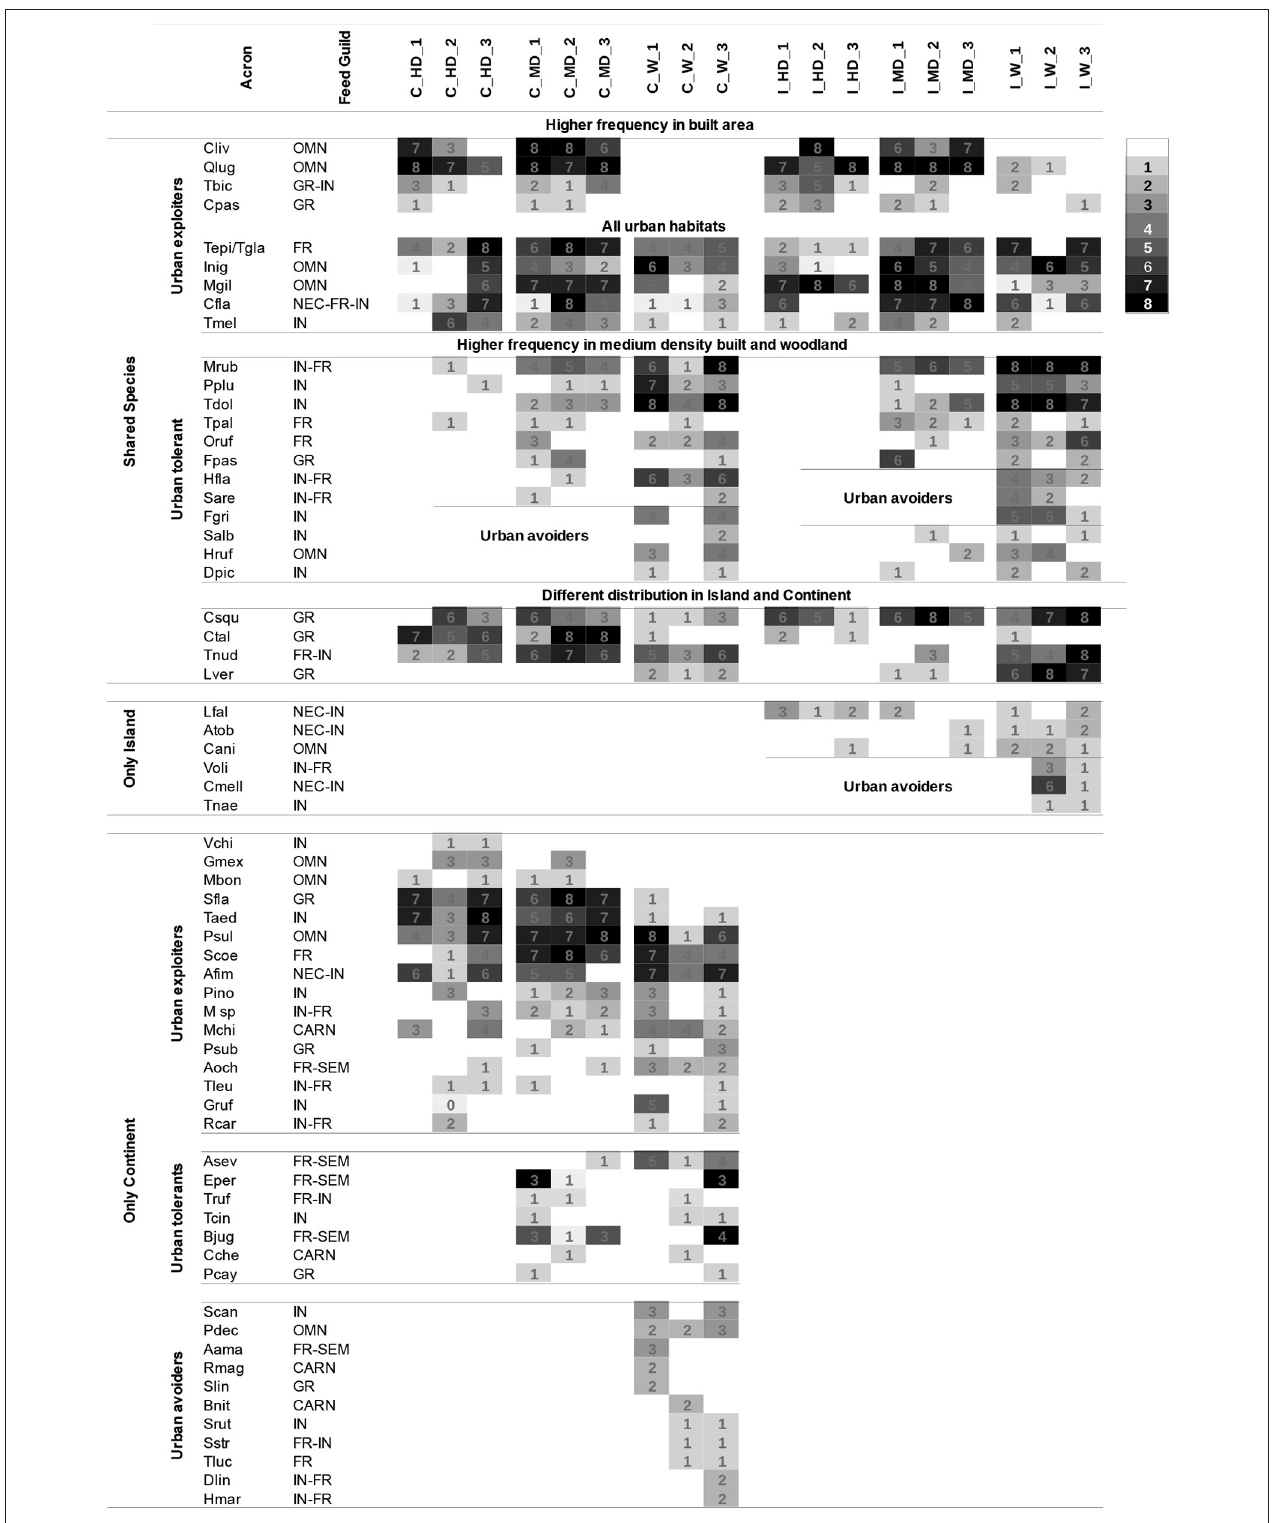
FIGURE 4 | Record of species at each habitat and region, ranked by the uses of the urban landscape and frequency. Grayscale: Frequency of detection of each species at each habitat type during 8 sampling days (refer to legends 1–8). The Paramacay woodland (C-W-2) was visited only in the dry season, i.e., four times out of the total of eight; therefore, the maximum detection frequencies were 4 in this unit. For the acronyms of localities, refer to Table 1 ; for the acronyms of bird species, refer to Supplementary Material 2 .